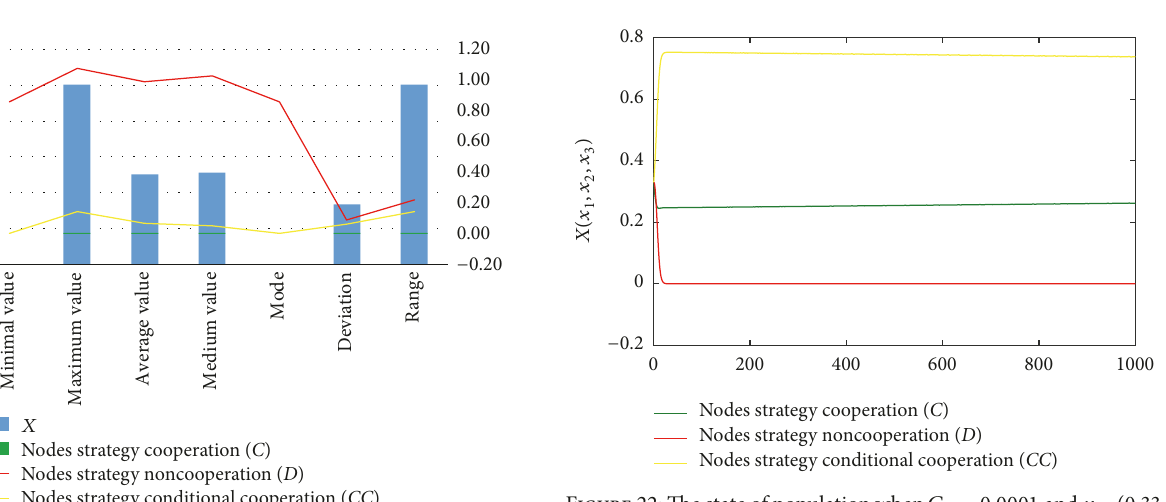
Figure 19: The state of population when 𝑋 = (0, 100, 53.64, 55, 0, 30.97, 100).